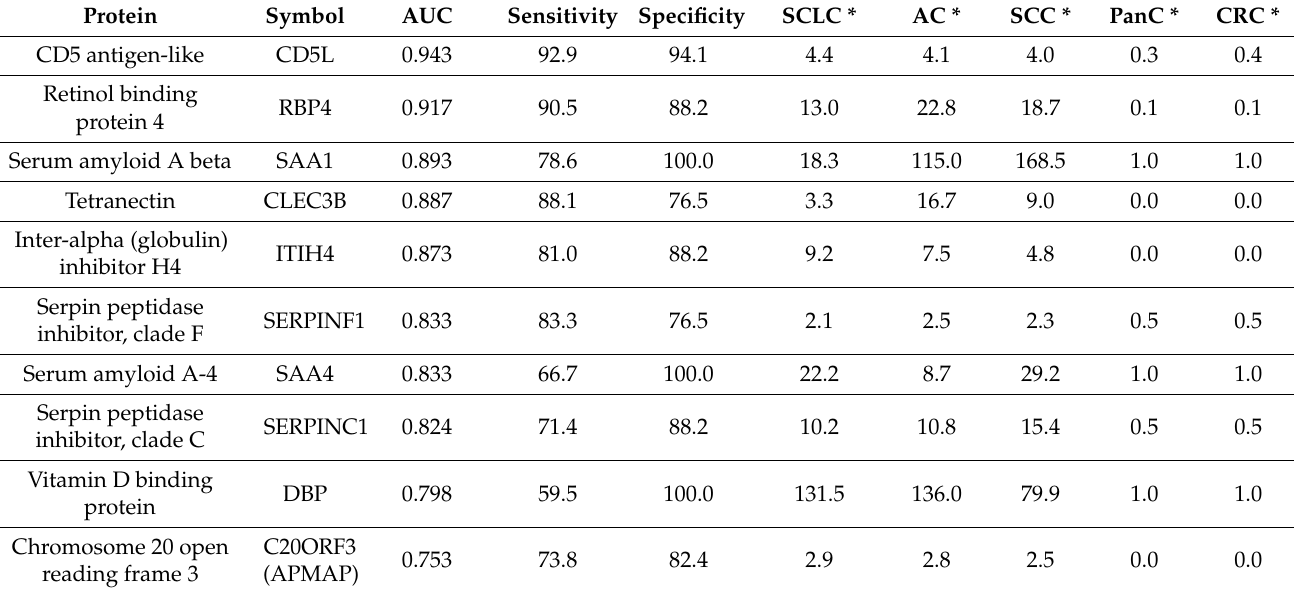
Table 2. Properties of top 10 candidate lung cancer biomarkers selected from the list of differentially upregulated proteins obtained using matrix-assisted laser desorption ionization–time-of-flight mass spectrometry (MALDI–TOF MS).